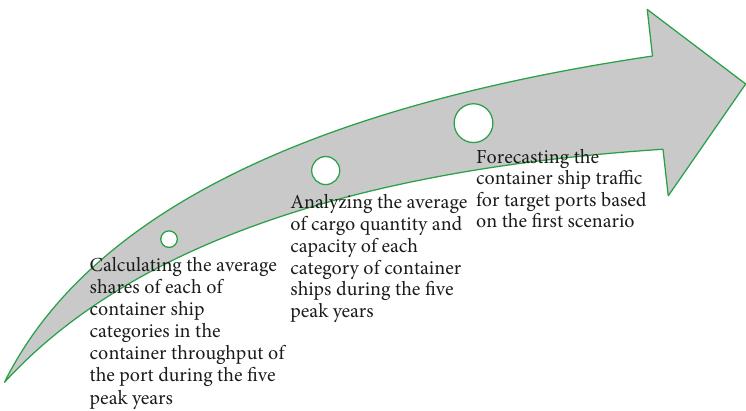
Figure 3: The procedure of forecasting container ship traffic in the first scenario.